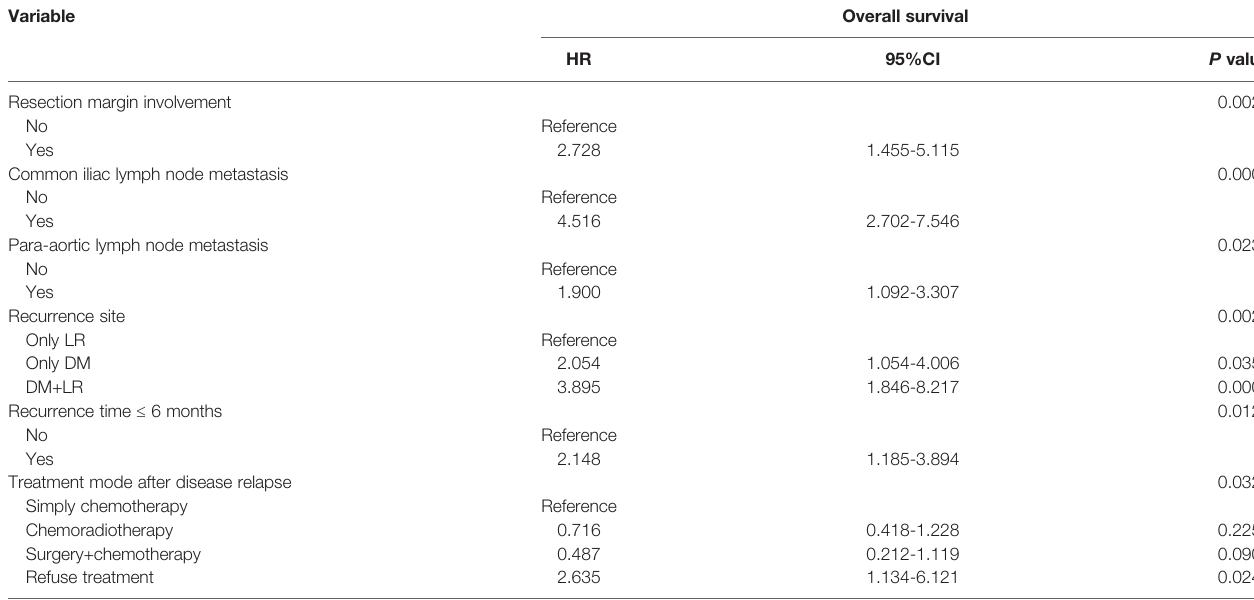
TABLE 5 | Cox proportional hazard analysis for prognositc factors associated with survival outcomes in recurrent cervical cancer.